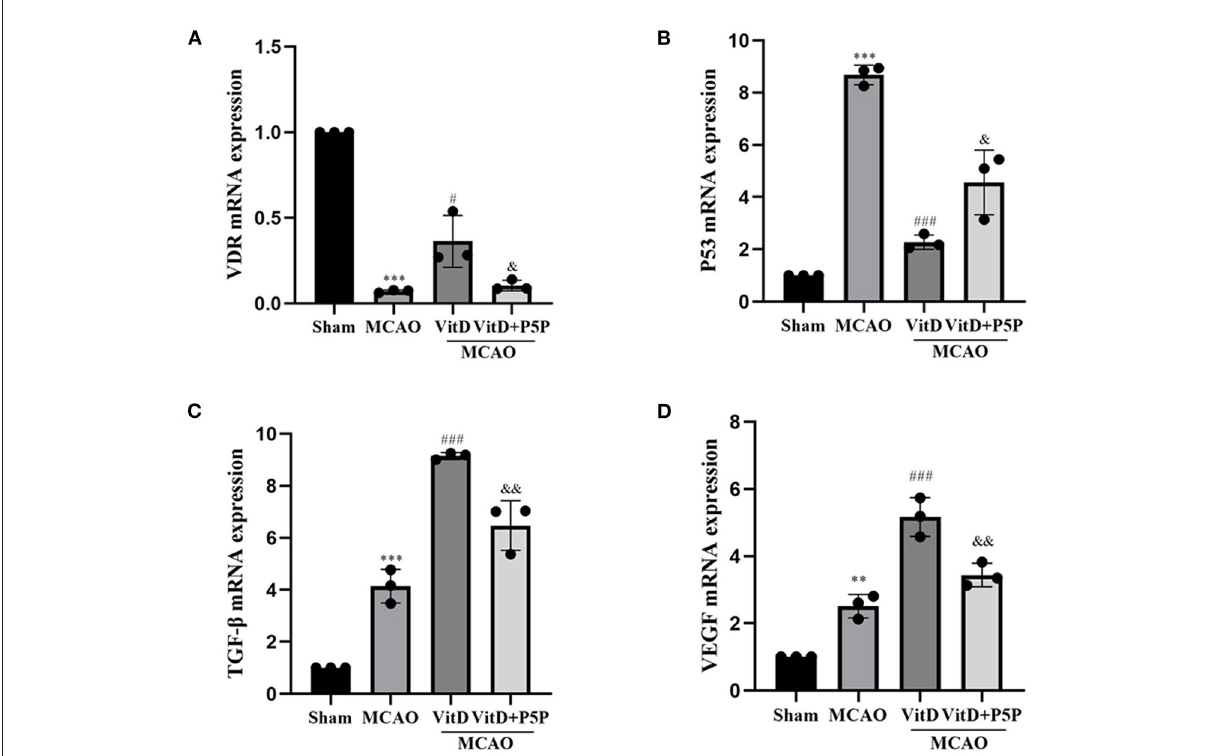
FIGURE7 Treatment with 1,25-D3 (Vit D), (A–D) the mRNA expression of VDR, VEGF, and TGF- β increased, and the mRNA expression of P53 decreased in the MCAO group. All values are shown as the mean ± SEM. ** P < 0.01, *** P < 0.001 (vs. Sham), # P < 0.05, ### P < 0.001 (vs. MCAO), & P < 0.05, && P < 0.01 (vs. VitD), n = 5. P5P, antagonist of VDR; Vit D,